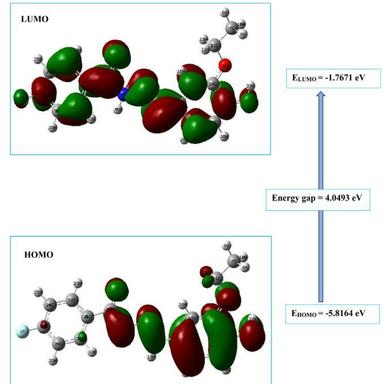
Frontier molecular orbitals of (E)-N- -(3-ethoxy-4-hydroxybenzylidene)−4 fluorobenzohydrazide.